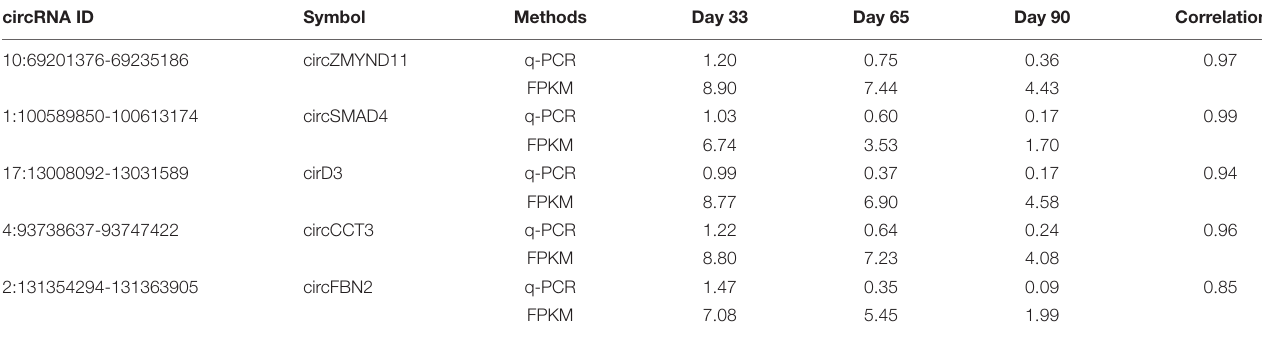
TABLE 1 | Validation of RNA-seq results by using quantitative RT-PCR. circRNA ID Symbol